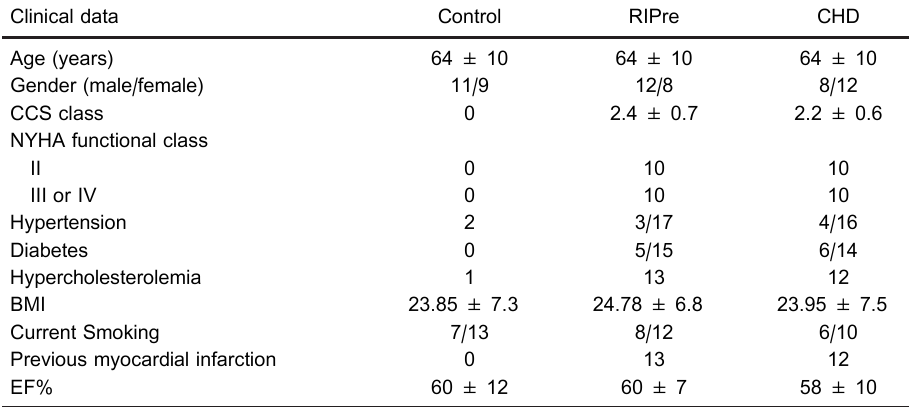
Table 1. Clinical, electrocardiographic and echocardiographic data of remote ischemic preconditioning (RIPre) and coronary heart disease (CHD) patients. Clinical data